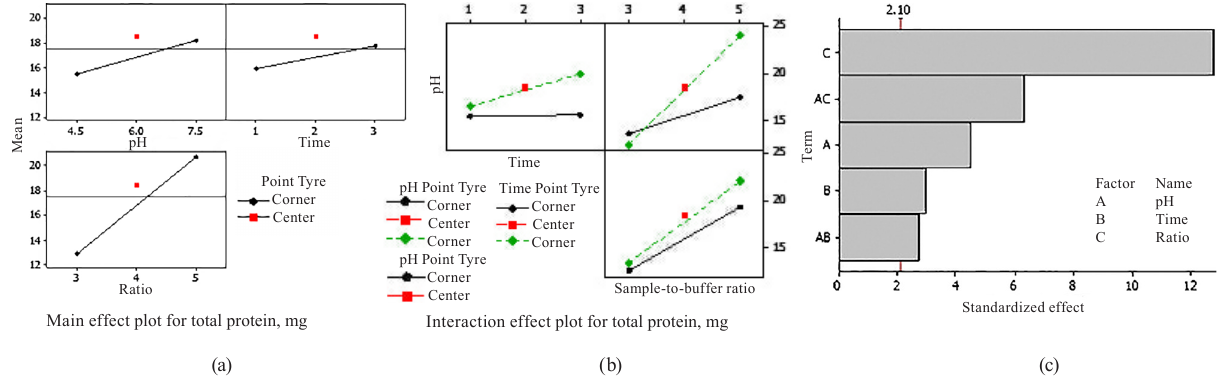
Figure 1 Main effects (a), interaction effects (b), and Pareto chart of extraction variables (c) on total protein of amylase from white pitaya peel